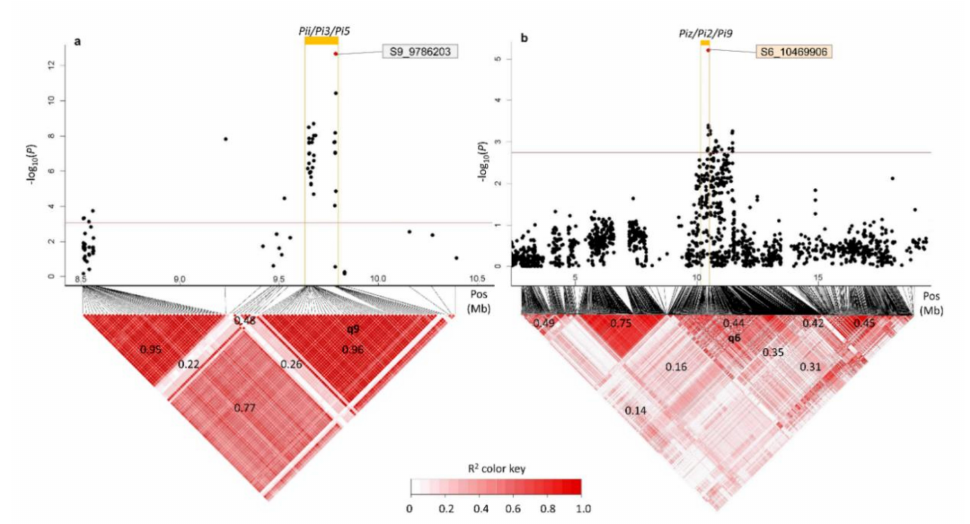
Figure 4. Zoomed-in views of major e ff ect quantitative trait locus (QTL) regions with reported gene clusters. ( a ) chromosome 9 from 8.5 to 10.5 Mb in tropical japonica showing the physical position of the gene cluster Pii / Pi3 / Pi5 and the linkage disequilibrium (LD) block where this gene cluster colocalizes. ( b ) chromosome 6 from 3 to 19 Mb in indica showing the physical position of the gene cluster Piz / Pi2 / Pi9 and the q6 LD block where this gene cluster colocalizes. For both panels, the single nucleotide polymorphism with the highest − log 10 ( p ) within each QTL is labelled and colored in red. Lower triangle shows average R 2 values within and between each LD